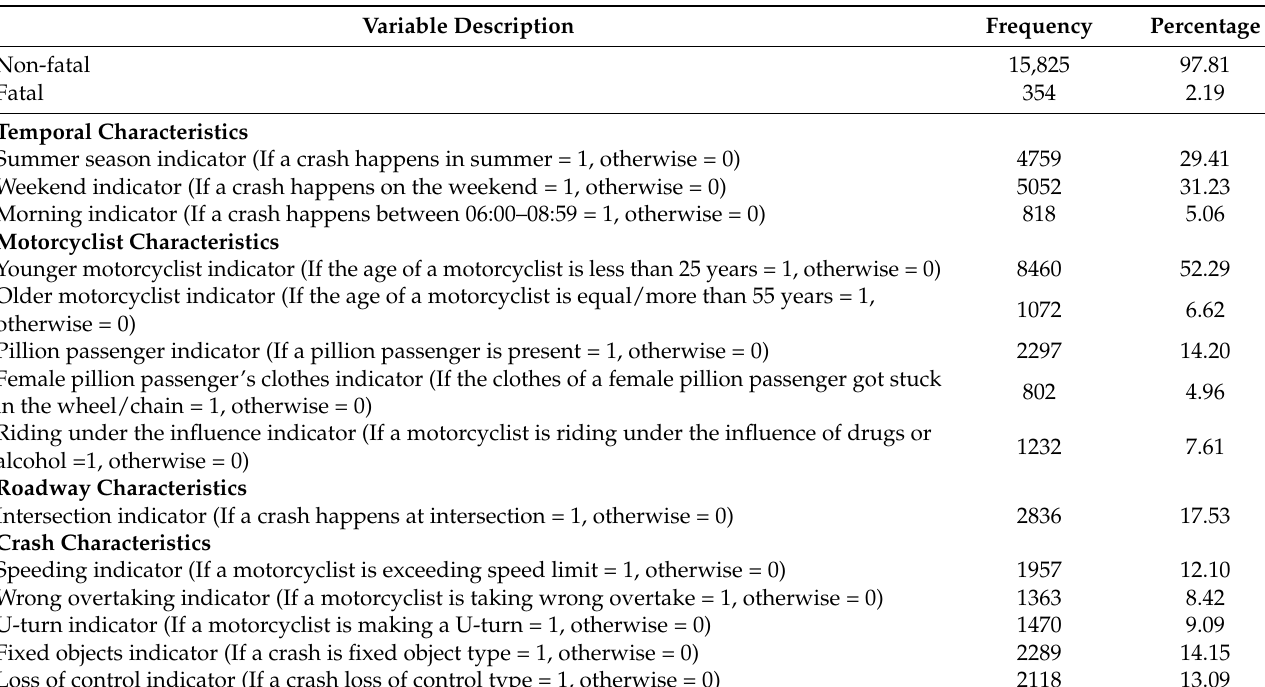
Figure 1. Location of the study area. Table 1. Descriptive statistics of the significant explanatory variables.